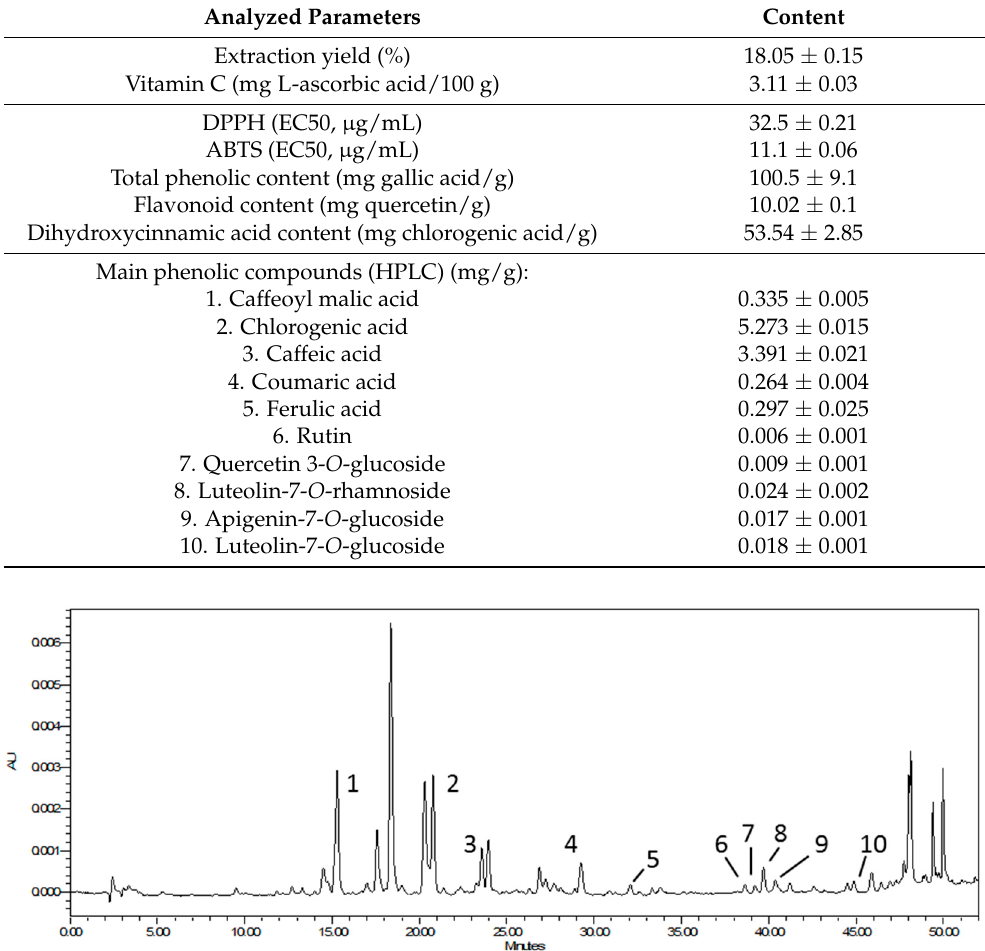
Table 2. Minimum inhibitory concentration (mg/mL) of black currant leaf extract.